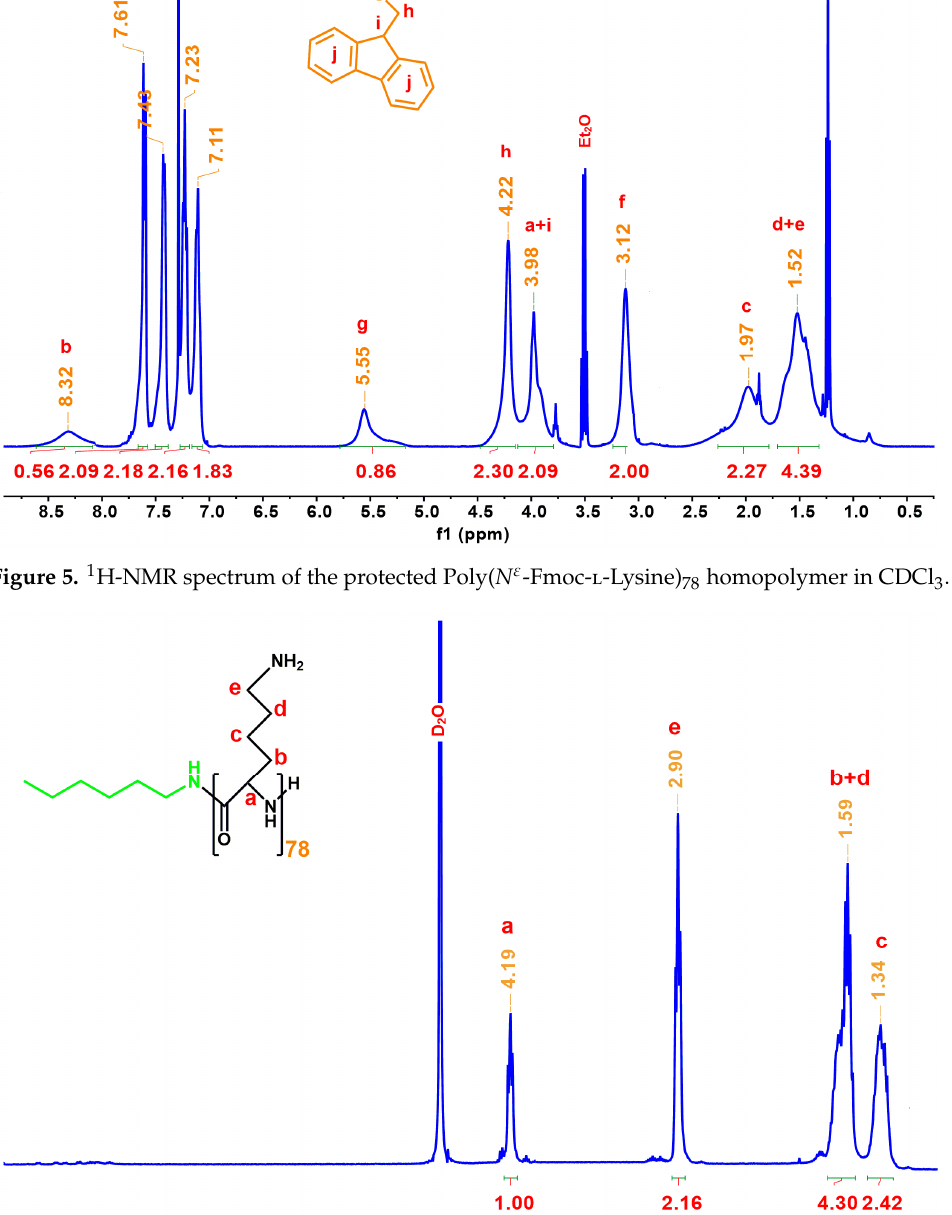
Figure 7. Size Exclusion Chromatography (SEC) eluograms of Poly( L -Lysine) 25 and Poly( L -Lysine) 78 homopolypeptides.